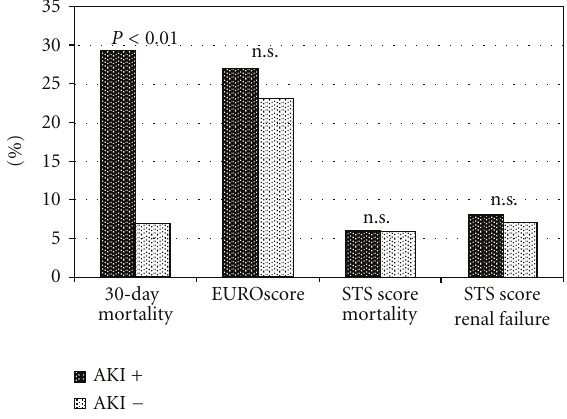
Table 4: Multivariate predictors of acute kidney injury.